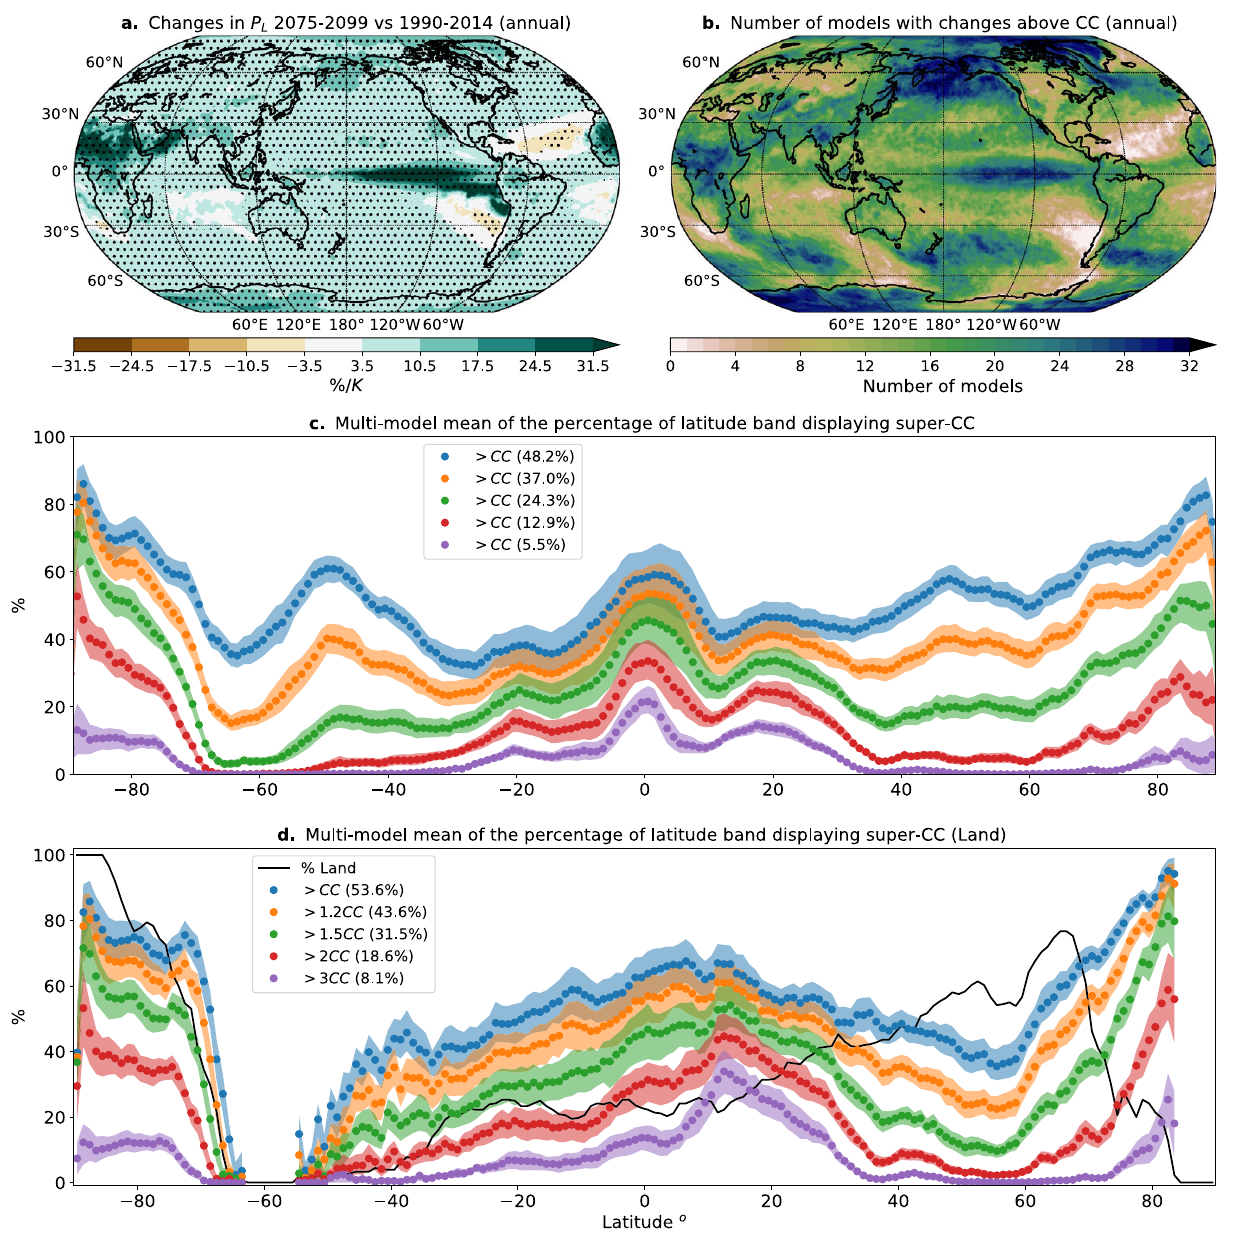
Figure 5. ( a ) Multi-model mean fractional change of the precipitation scale comparing 2075–2099 vs. 1990–2014. Change is normalized by each model global mean temperature change prior to aggregating. Dots show regions in which at least 80% of the models agree in the sign of the change. ( b ) Number of models (out of 32) that display increases in P L (2075-2099 vs 1990-2014) above the nominal CC scaling of 7% / K. ( c ) Multi- model mean of the fraction of latitude band displaying increases above CC ( 7% / K), 1.2 × CC , 1.5 × CC , 2 × CC and 3 × CC as a function of latitude. Numbers in parentheses are global averages. ( d ) Same as ( c ) but only considering land points. The solid black line represents the percentage of land in the latitude band. Shading in ( c , d ) denotes the 5th-95th percentile of the estimation of the mean from a bootstrap ensemble (see Methods). Maps were generated using Python’s 30 Matplotlib 31 Basemap 32